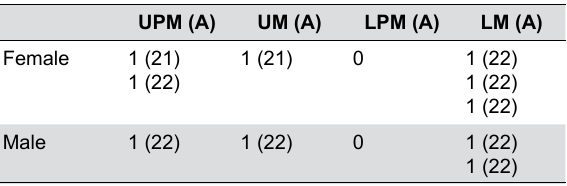
Figure 7 - Clinical appearance of some EF restorations at one-year evaluation Table 2- Distribution of failed restorations according to gender, age and type of